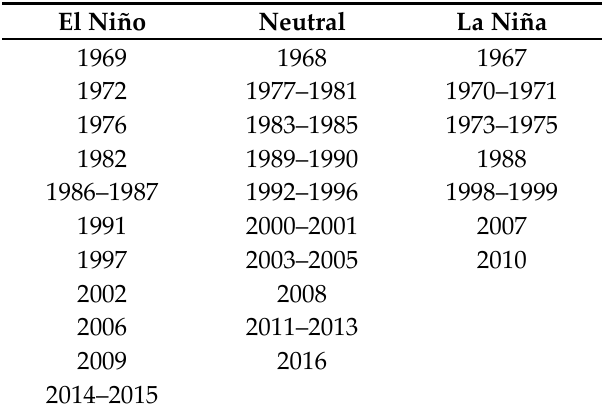
Table 1. List of ENSO years used here. The years are taken from